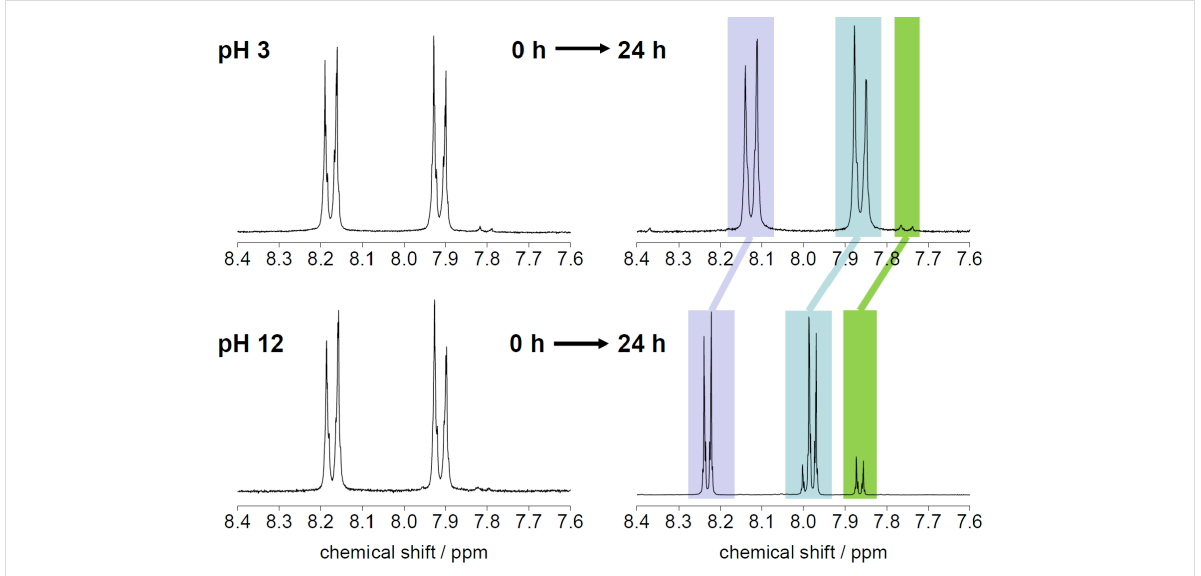
Figure 3: Representative NMR spectra of CBAmPEG after incubation at pH 3 for 0 h (left top) and 24 h (right top) and after incubation at pH 12 after 0 h (left bottom) and 24 h (right bottom). All data are for 37 °C. See Experimental section for signal assignments. Colored areas highlight the corre- sponding signals that are shifted after treatment at pH